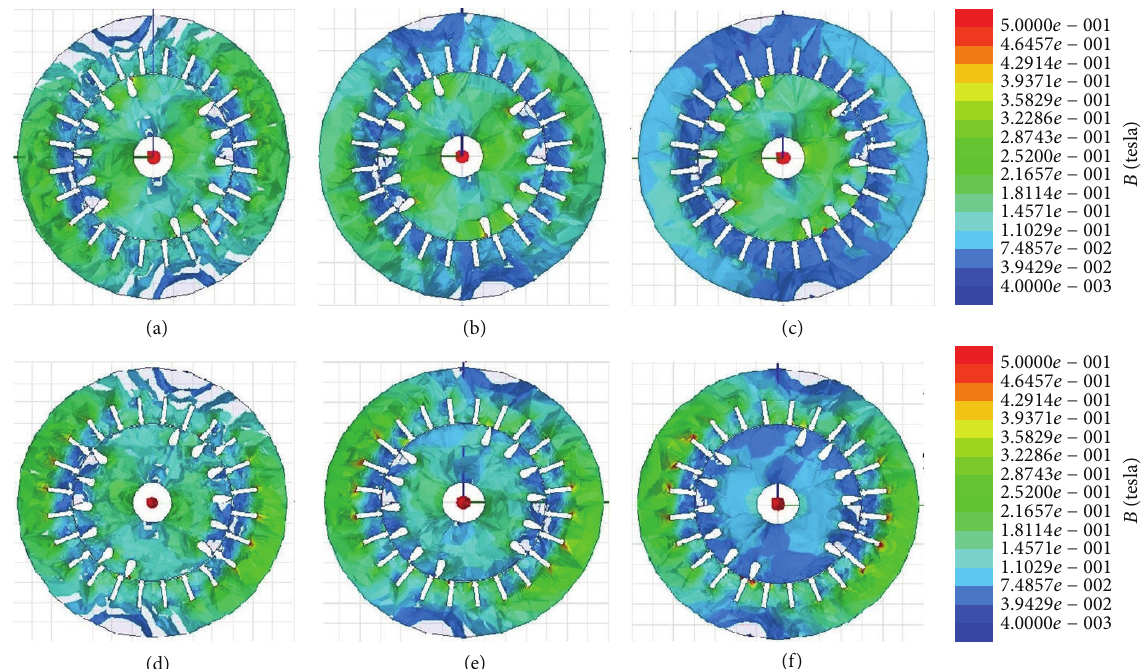
Figure 18: Section MFD distribution, respectively, under (a) 0 mm AAGE (back), (b) 5 mm AAGE (back), (c) 10mm AAGE (back), (d) 0mm AAGE (front), (e) 5mm AAGE (front), and (f) 10mm AAGE